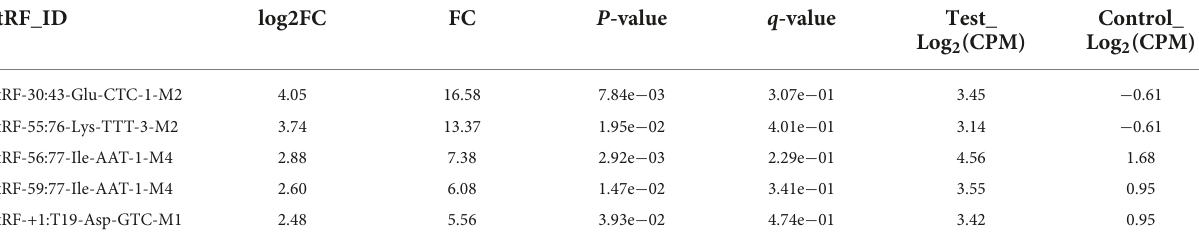
TABLE 4 Top five tsRNAs with the highest expression fold